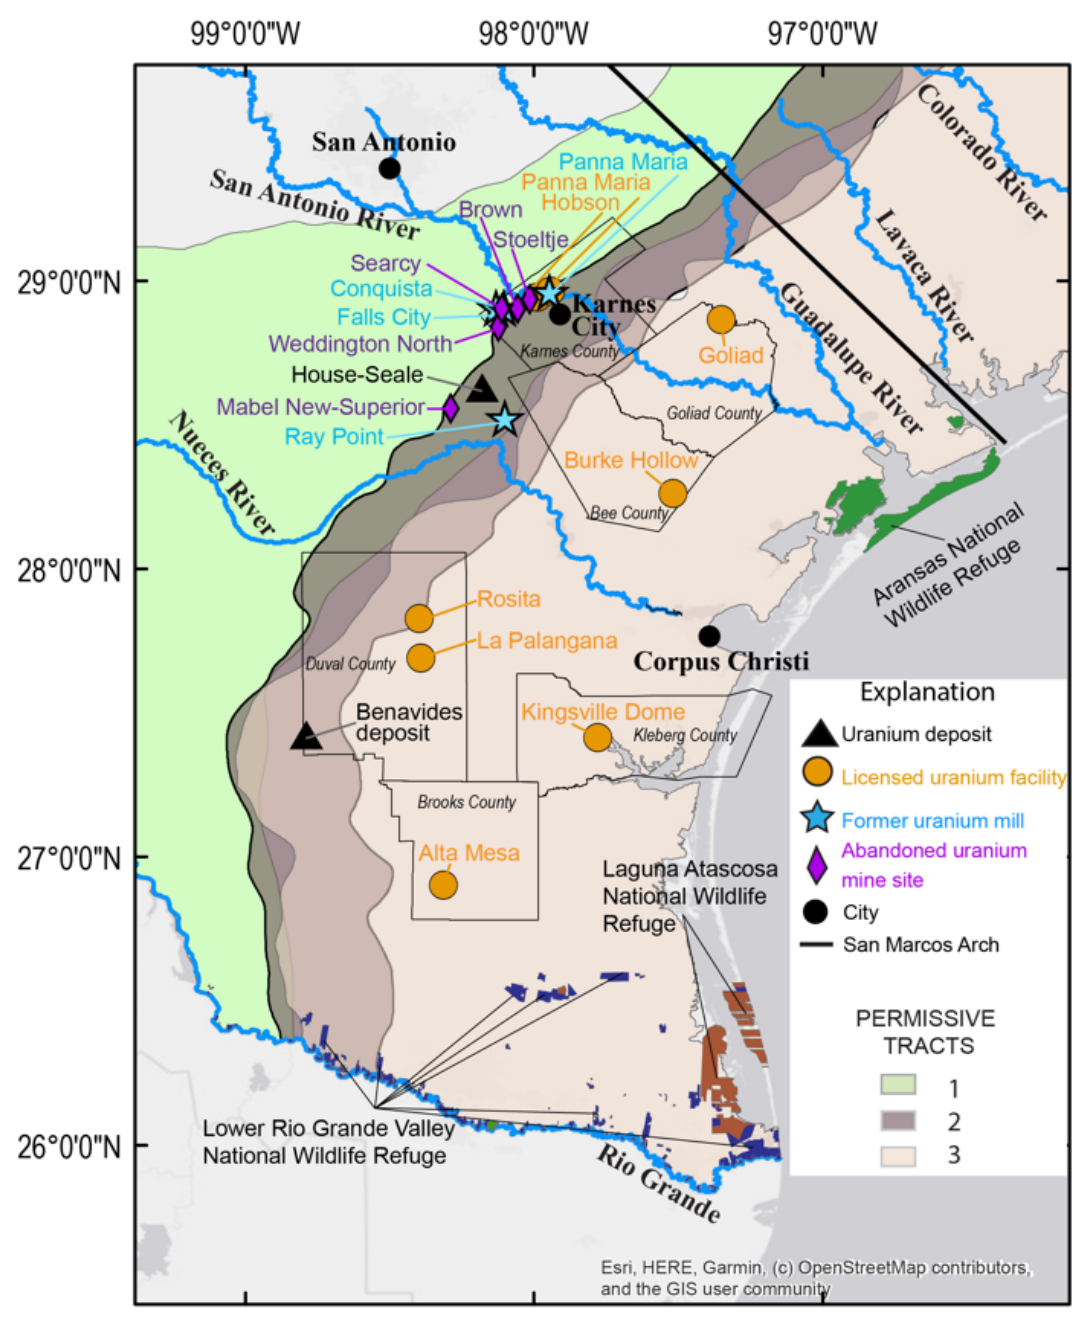
Figure 3. Locations of uranium deposits, licensed uranium facilities, former uranium mills, aban- doned uranium mines, and wildlife refuges mentioned in this report.